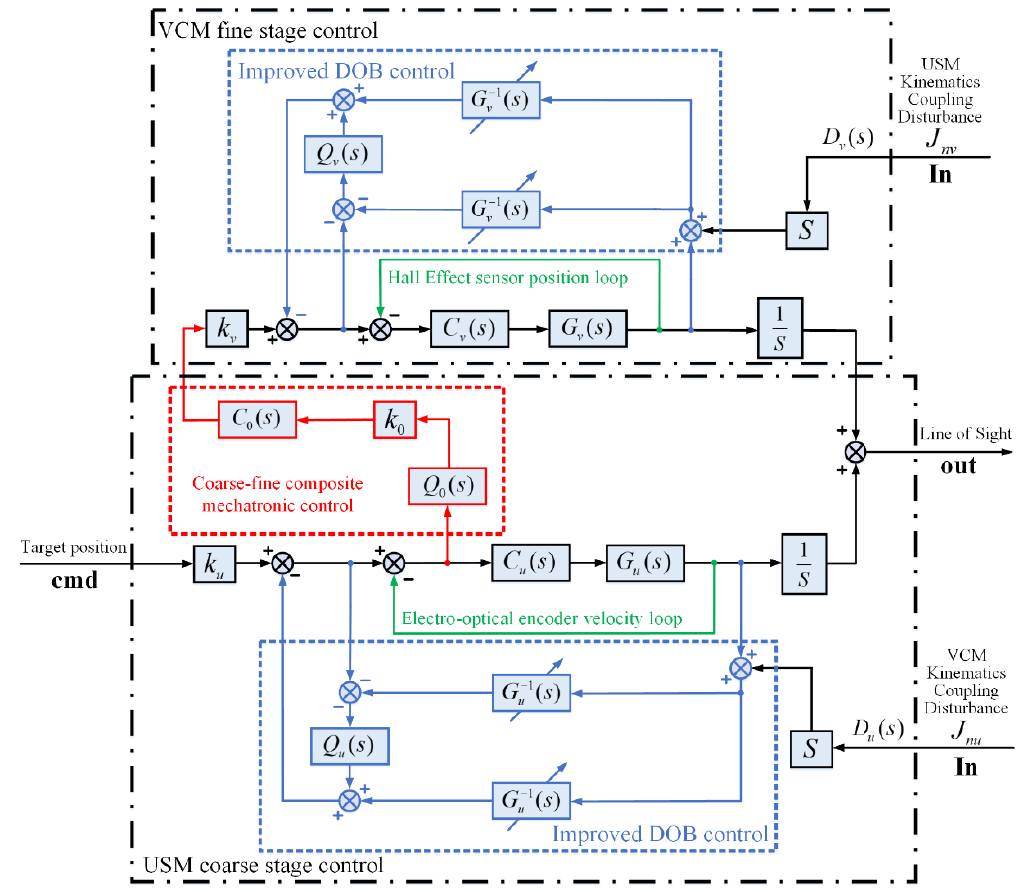
Figure 16. The coarse-fine composite mechatronic controller block diagram.